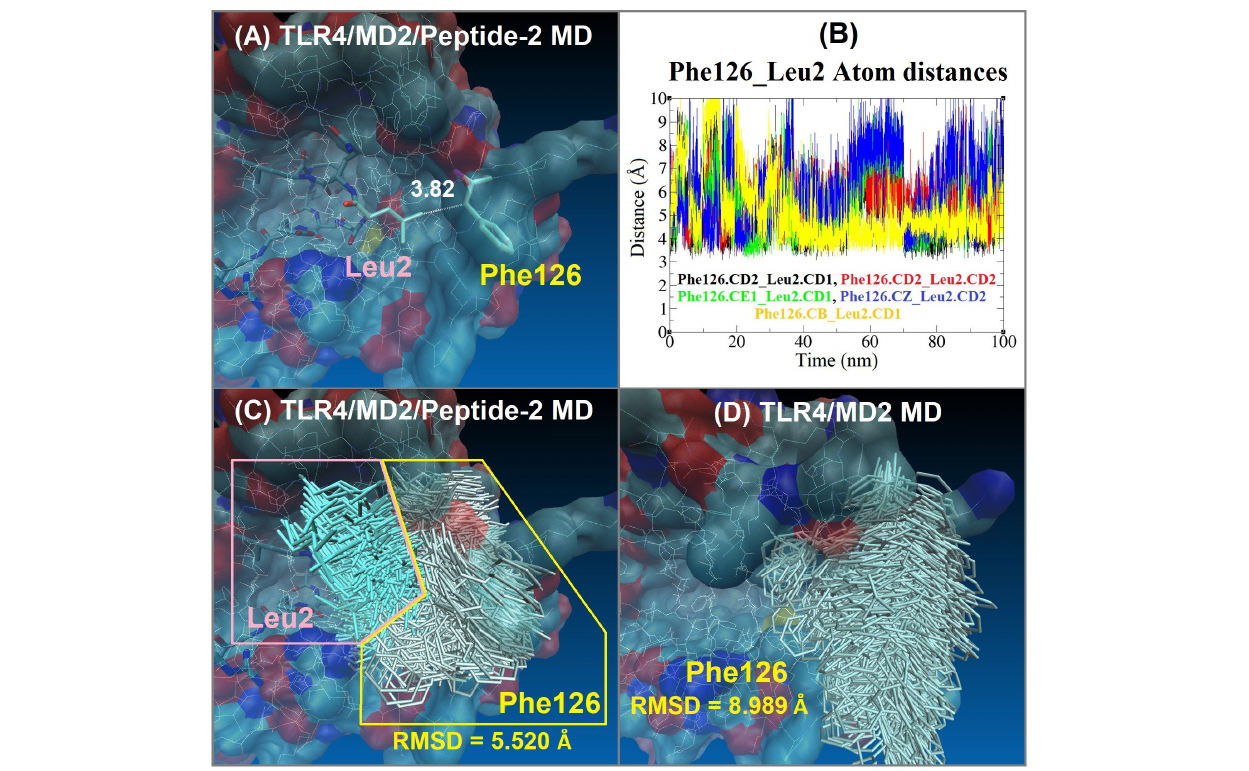
FIGURE 8 | Interaction between Phe126 of MD2 and Leu2 of Peptide-2 observed by MD simulations at 310 K for 100 ns. (A) Interaction distance between Peptide-2 Leu2.CD1 and MD2 Phe126.CB, yellow line in plot (B) (the most consistent interactions in terms of distance). (B) Distance (Å, Y axis) vs. time (nm, X axis) plot between different carbon atoms of Phe126 and Leu2 residues, merging all the distance vs. time plots allows observing that these residues are at a distance of less than 4 Å during practically the entire simulation. CB: Carbon beta of Phenylalanine residue. CE1: Carbon epsilon 1 of Phenylalanine residue. CD1, CD2: Carbon delta 1 and 2 of Leucine or Phenylalanine residues. CZ: Carbon zeta of Phenylalanine residue. (C) Side chain MD-trajectories superposition of Phe126 (silver) and Leu2 (light blue) residues, remaining very close during the simulation time. Plots (A–C) correspond to the TLR4/MD2/Peptide-2 MD simulation at 310 K for 100 ns. (D) Side chain MD-trajectories superposition of Phe126 (silver) observed with the TLR4/MD2 MD simulation in absence of Peptide-2 at 310 K for 100 ns [panels (C,D) trajectories were aligned with VMD “Trajectory tool” and were tracked every 10 steps over a total of 10,000, giving a total of 1,000 superposed conformations]. Average RMSD values of Phe126 side chain atoms are shown at the bottom of panels (C,D) (side chain hydrogen atoms were not taken account for these